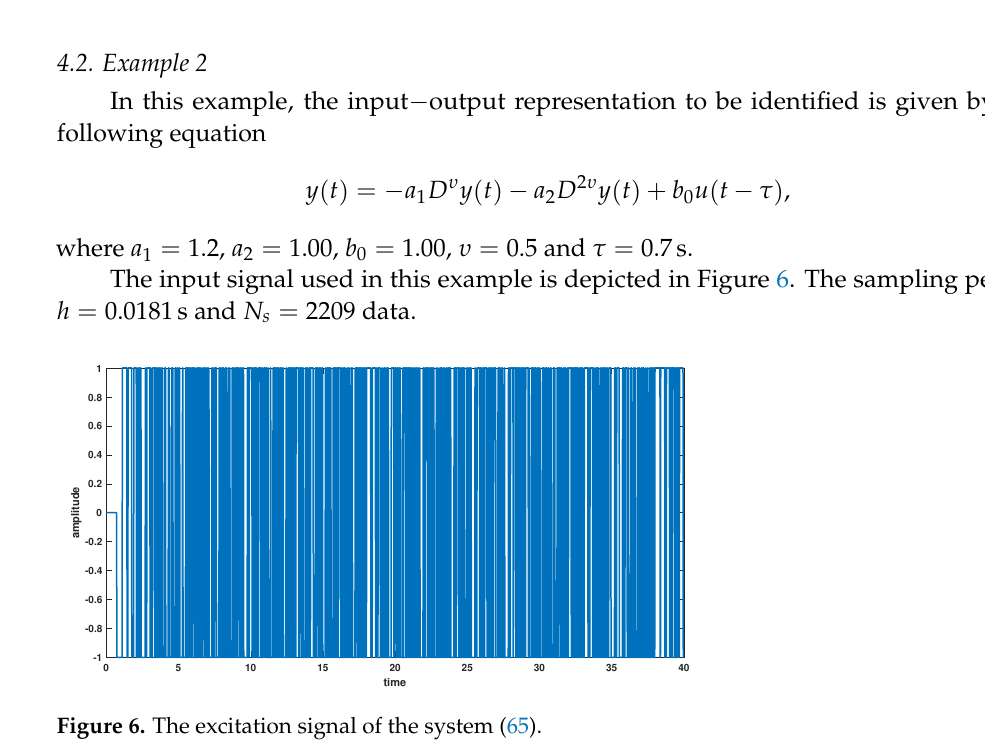
Figure 6. The excitation signal of the system (65). The Bode diagram of the system defined by the Equation (65) is plotted in Figure 7.